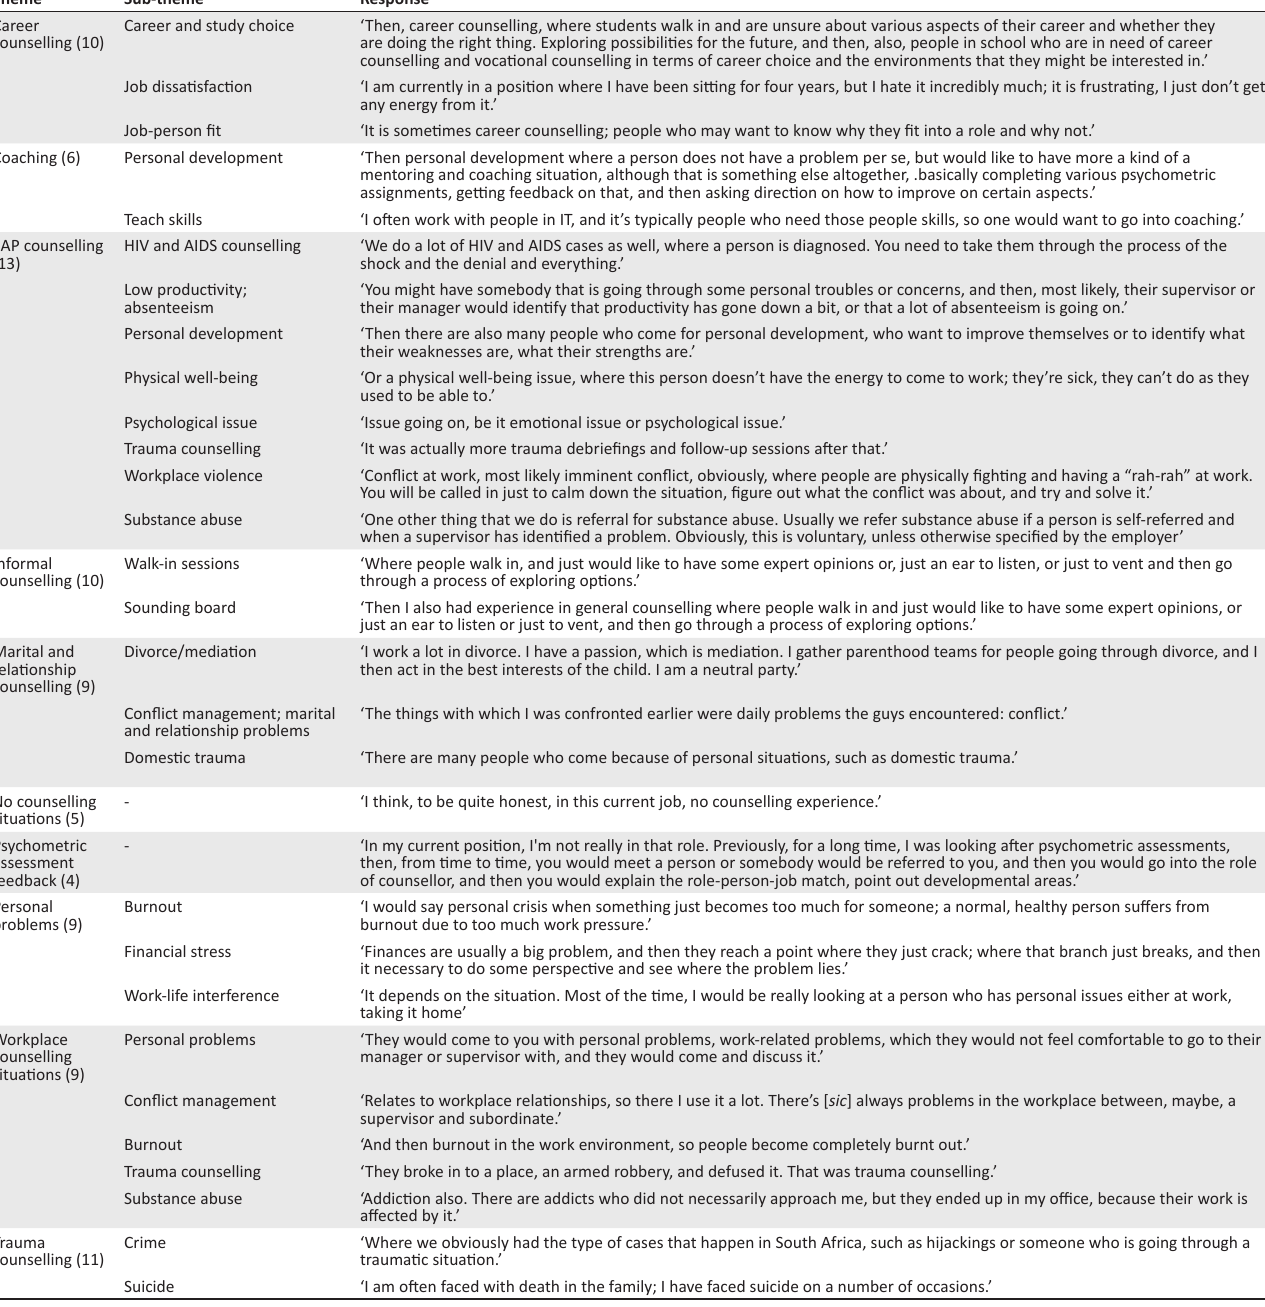
TABLE 2: Counselling situations that I-O psychologists face. Theme Sub-theme Response Career Career and study counselling (10)